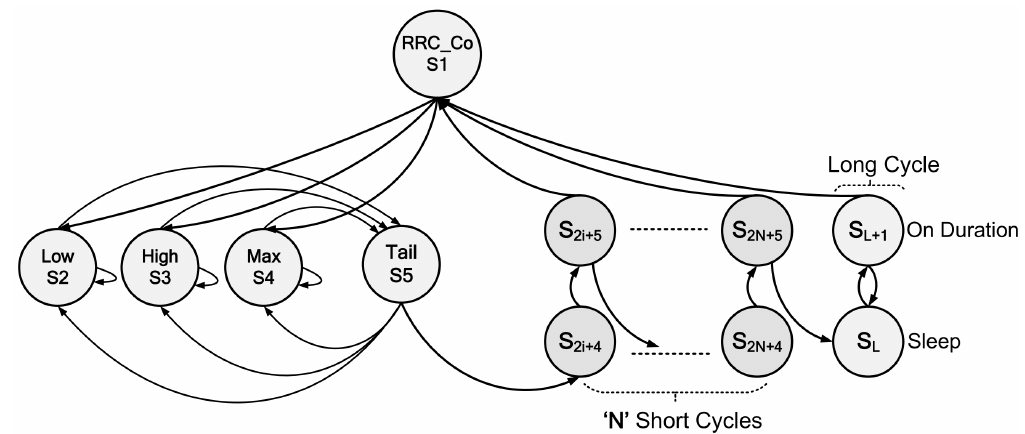
Figure 3. The proposed semi-Markov-based DRX model for MTC in